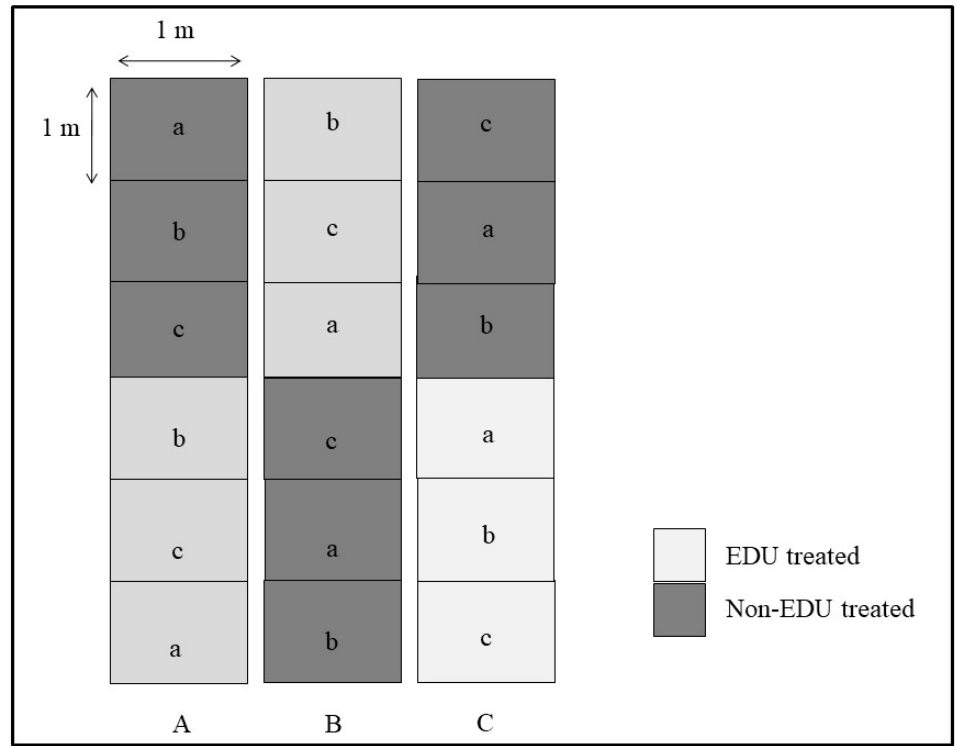
Figure 5. The layout of the whole plot, consisting of three main blocks (A, B and C) with twosub-plots (EDU-treated and non-EDU-treated) and a further threesub-subplots (a, b and c). Here, a, b and c are three different wheat cultivars (HD 2987, PBW 502 and Kharchiya 65).